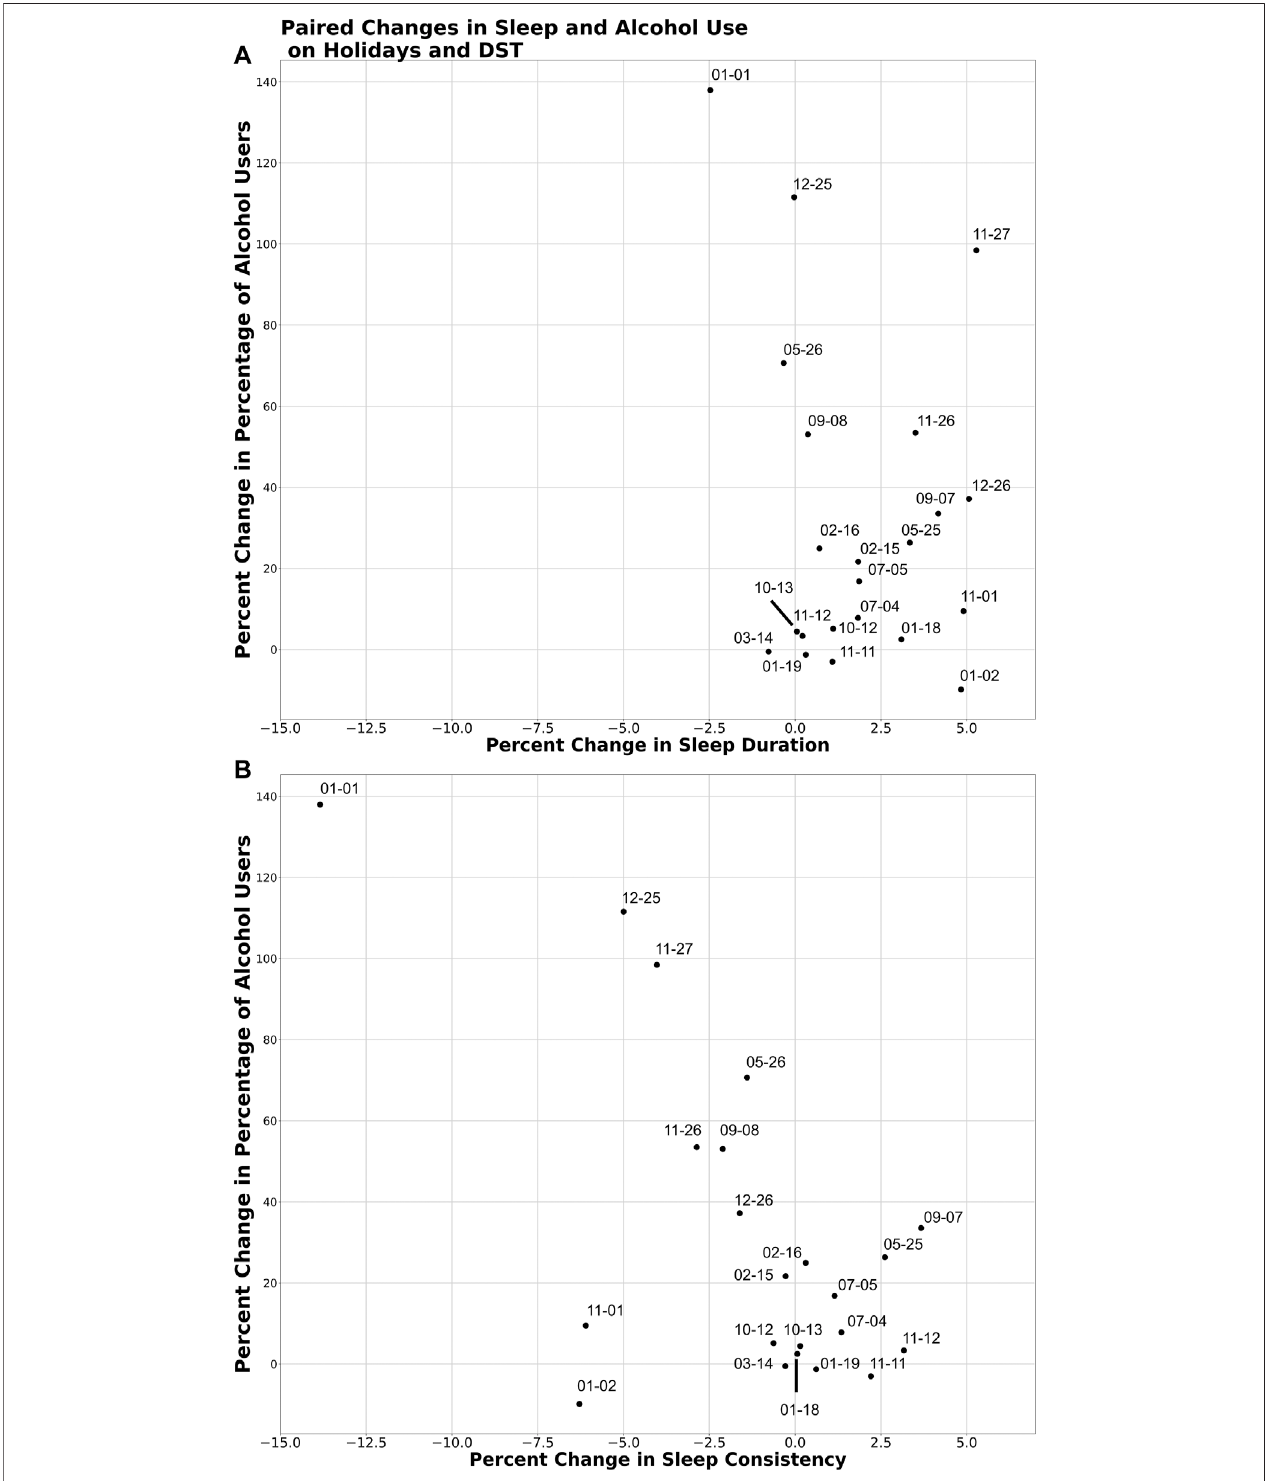
FIGURE 3 | Paired changes to alcohol use and (A) sleep duration and (B) sleep consistency during DST transitions and on holidays and their eves compared to baseline. The percent change in the point prevalence of alcohol use and each of sleep duration and sleep consistency were plotted. Correlation coef fi cients were calculated to estimate the linear relationship between each of these paired variables.